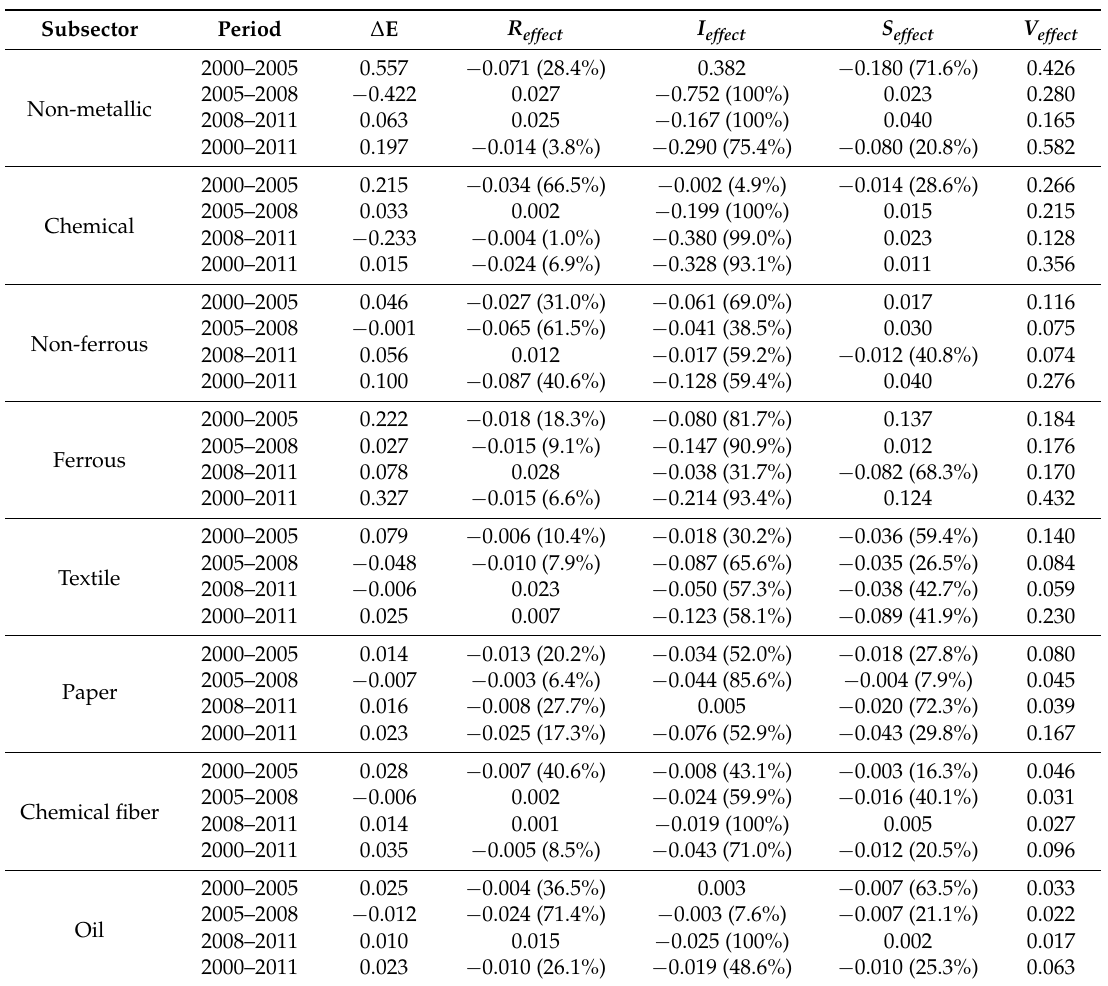
Table 5. Decomposition results of SO 2 emission changes in the seven industrial subsectors of Jiangsu province (unit: